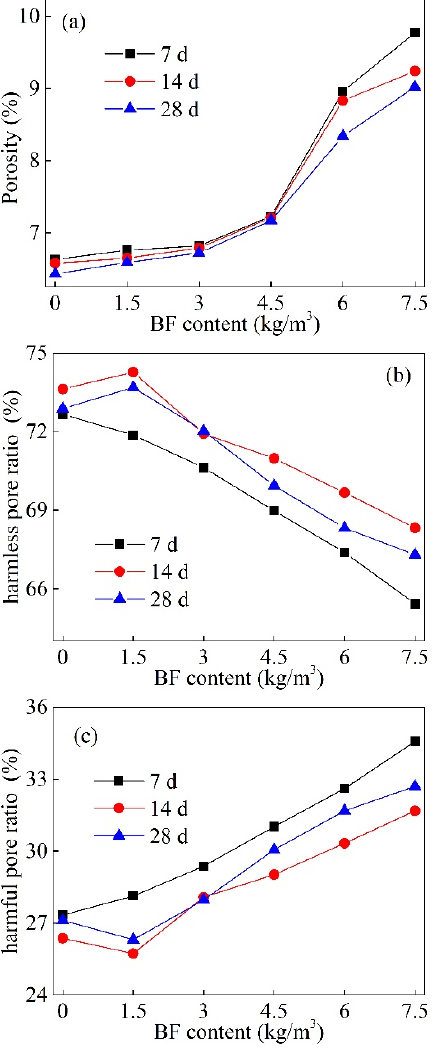
Figure 12. Pore ratio of different BF contents ( a ) porosity, namely, the ratio of total pores to the volume of BF concrete; ( b ) the ratio of harmless pores to the total pores; ( c ) the ratio of harmful pores to total pores.